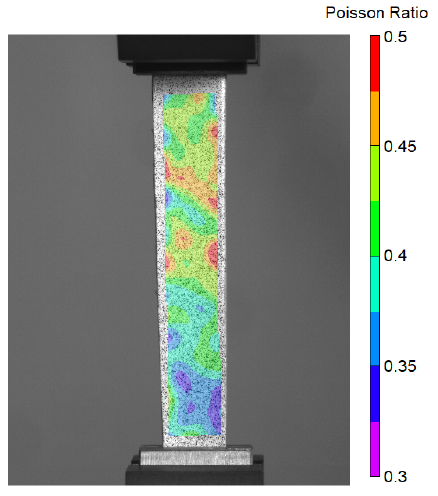
Figure 16. Poisson ratio results for the blade